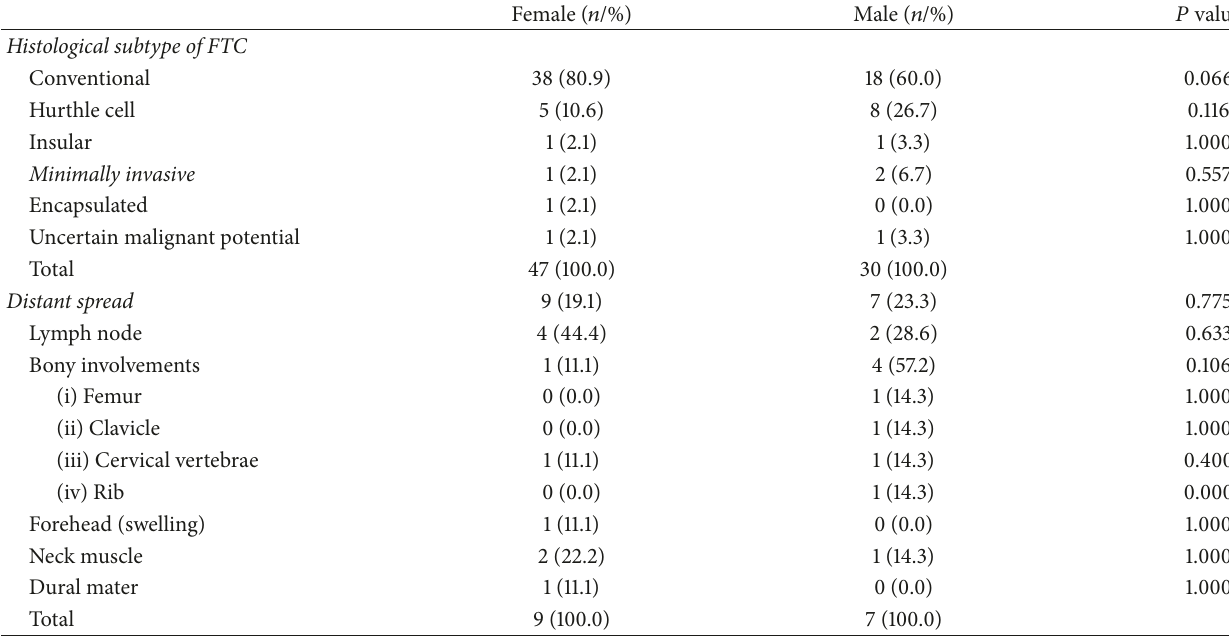
Table 2: Histological subtypes and distant spread of FTCs at the time of histological diagnosis in females and males. Female ( 𝑛